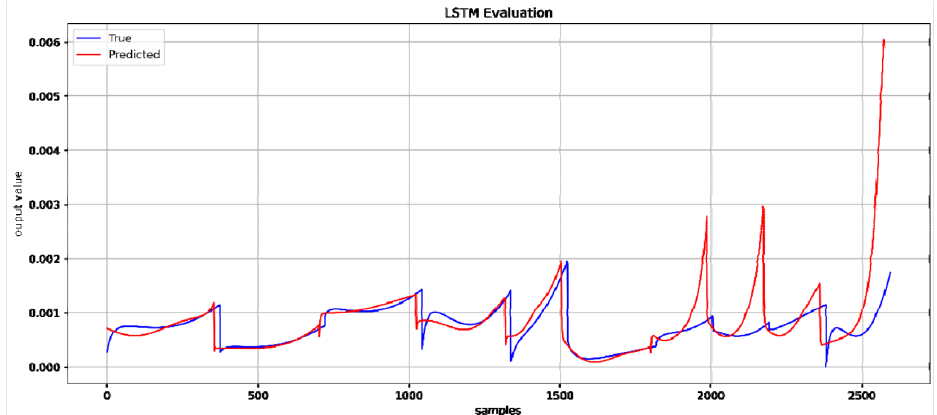
Figure 21. Relationship between predicted and measured values using LSTM.